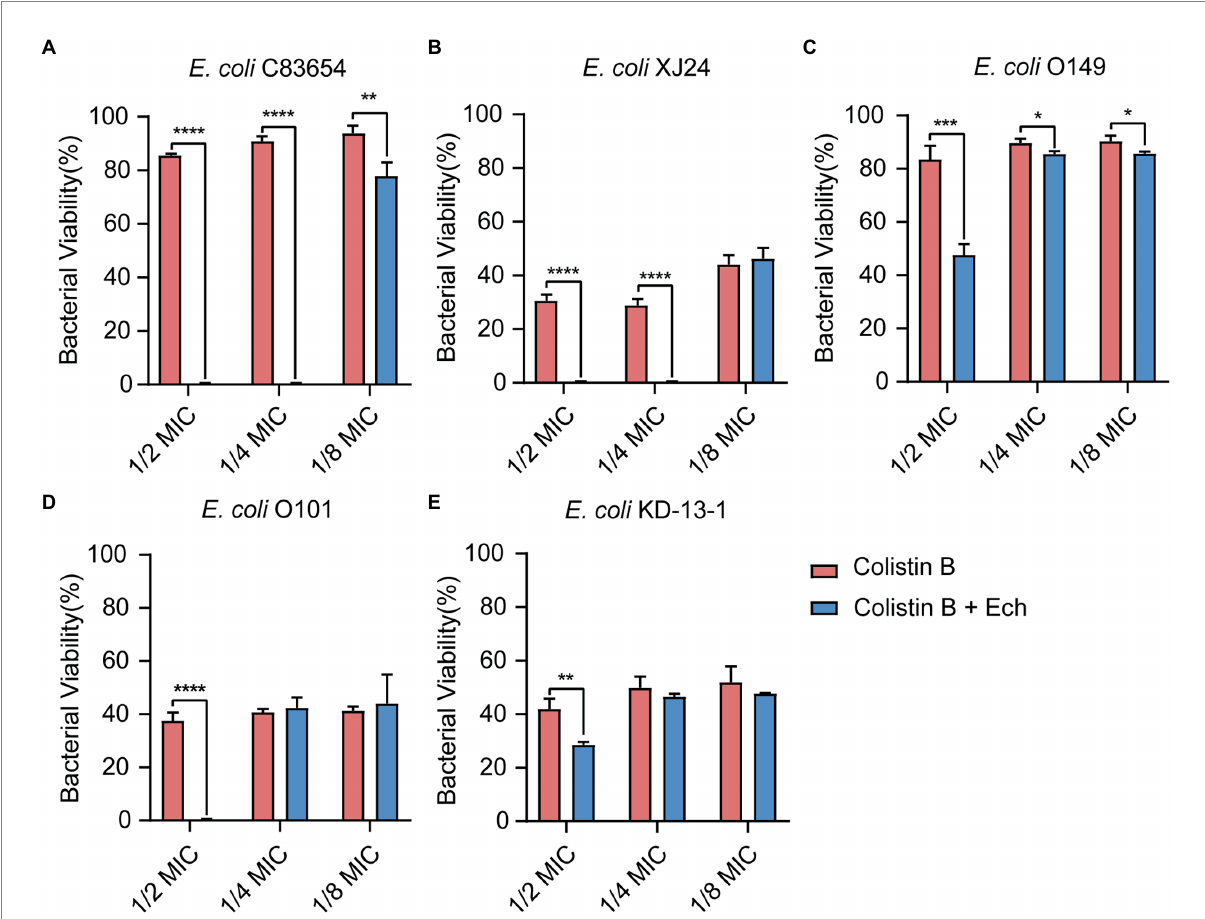
FIGURE 9 Synergistic effects of Ech (50 μ M) with Colistin B in five different E. coli on bacterial viability. E. coli (A) C83654, (B) XJ24, (C) O149, (D) O101, (E) KD-13-1. Data represent means ± SD of three experiments conducted in triplicate. * = p < 0.05; ** = p < 0.01; *** = p < 0.001; **** = p <